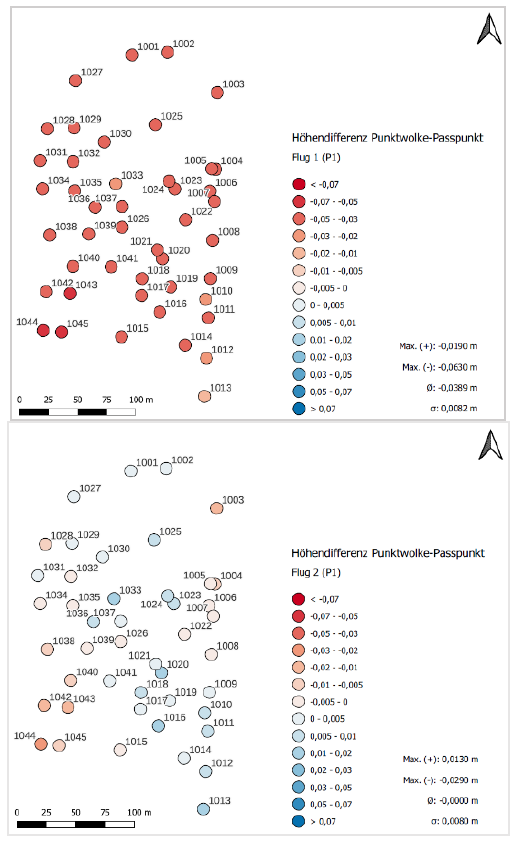
Figure 7 . Colour-coded deviations in altitude at the check points - aerial flight 1 (top) and flight 2 (bottom) each with the Zenmuse P1 camera.